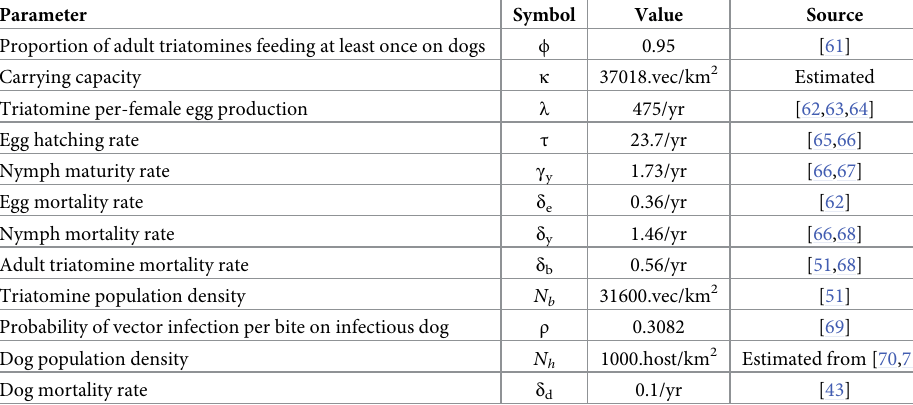
Table 1. Key model input parameters, values, and